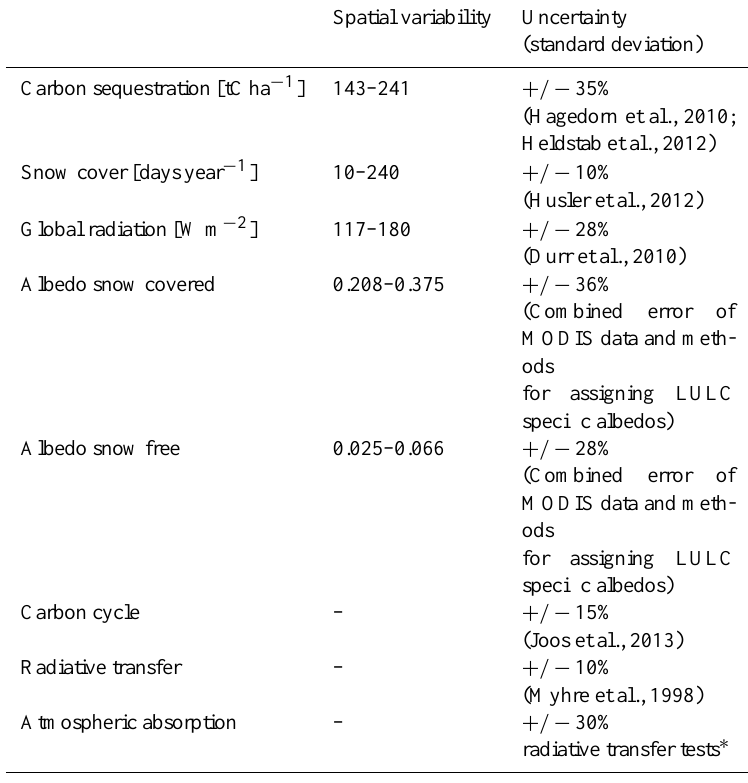
Table A3. Spatial variability and uncertainties applied in the sensitivity